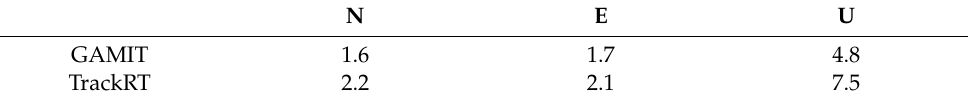
Table 1. Two kinds of monitoring results NEU direction RMS precision statistics (Unit: mm).